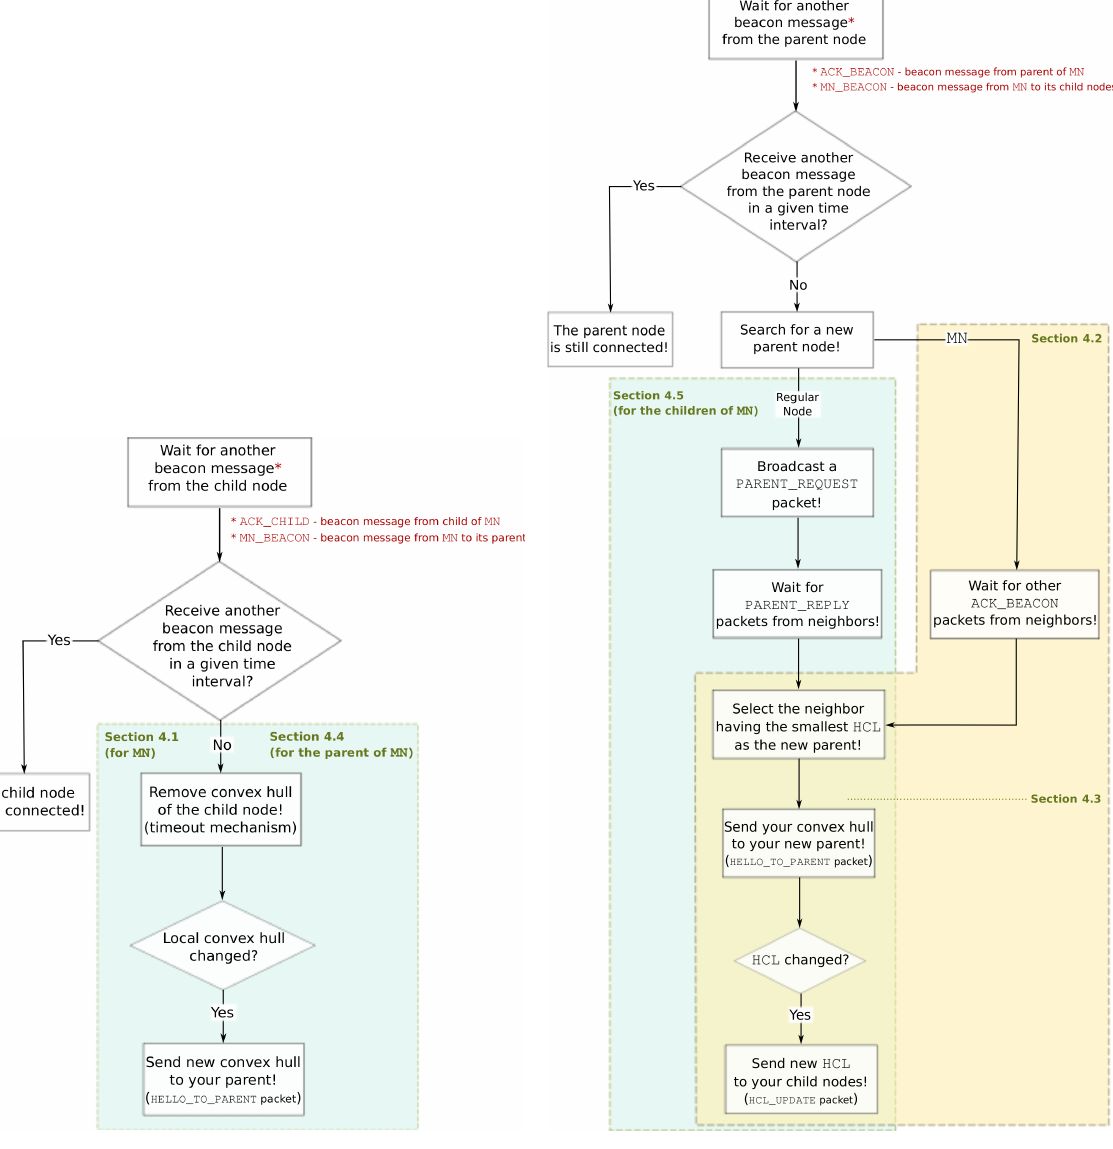
Figure 6. Fundamental operations of local updating